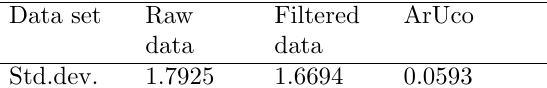
Table 2: Standard deviations of plane distances, given in centimeters. It is noted that the estimated distance was initiated by the first lidar and attitude measurements. Data set Raw